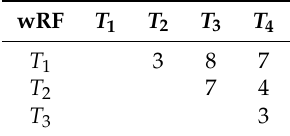
Figure 4. Four weighted trees with the same lineages A, B and C. Table 1. The weighted RF distances wRF among T 1 , T 2 , T 3 and T 4